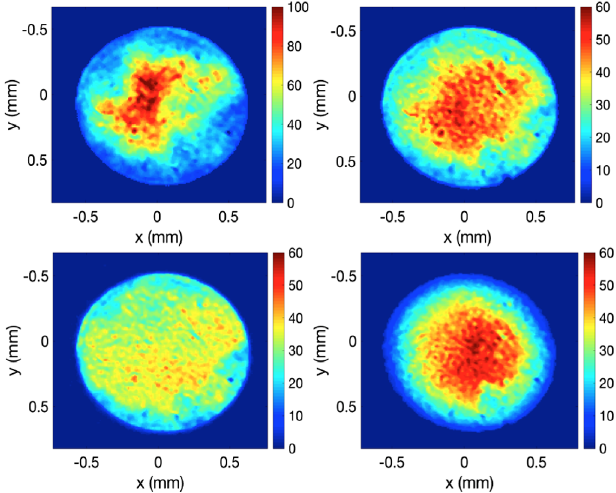
FIG. 4. Example VCC images of laser shaping. Top left is the original laser profile. Top right is cut-Gaussian shaping (error: 18%, efficiency: 77%). Bottom left is flat-top shaping (error: 23%, efficiency: 71%). Bottom right is parabolic shaping (error: 19%, efficiency: 67%). Note that the color scale for the shaped profiles (top right, lower left, and lower right) is 60% of the color scale of the original beam image (top left), in order to show stronger contrast. Since the DMD can only reduce intensity, the fine structures in the shaped profiles, for example the lower right corner of the flat-top image, come from the corresponding low intensity part of the original beam. This indicates that the shaping performance also depends on the uniformity of the initial